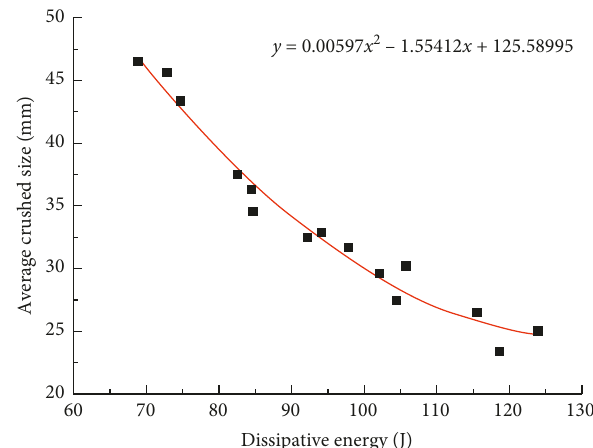
Figure 12: Relationship between the average crushed size and the dissipative energy of vertical-bedding shale under dynamic compression.